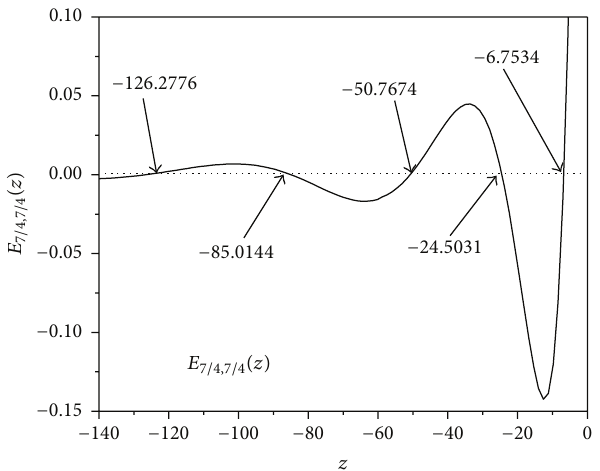
separation distinguishing consecutive subphases. The line separating subphase [ 101/∞ ] from [ 103/∞ ] is also drawn for perspective. Points on the boundary lines separating